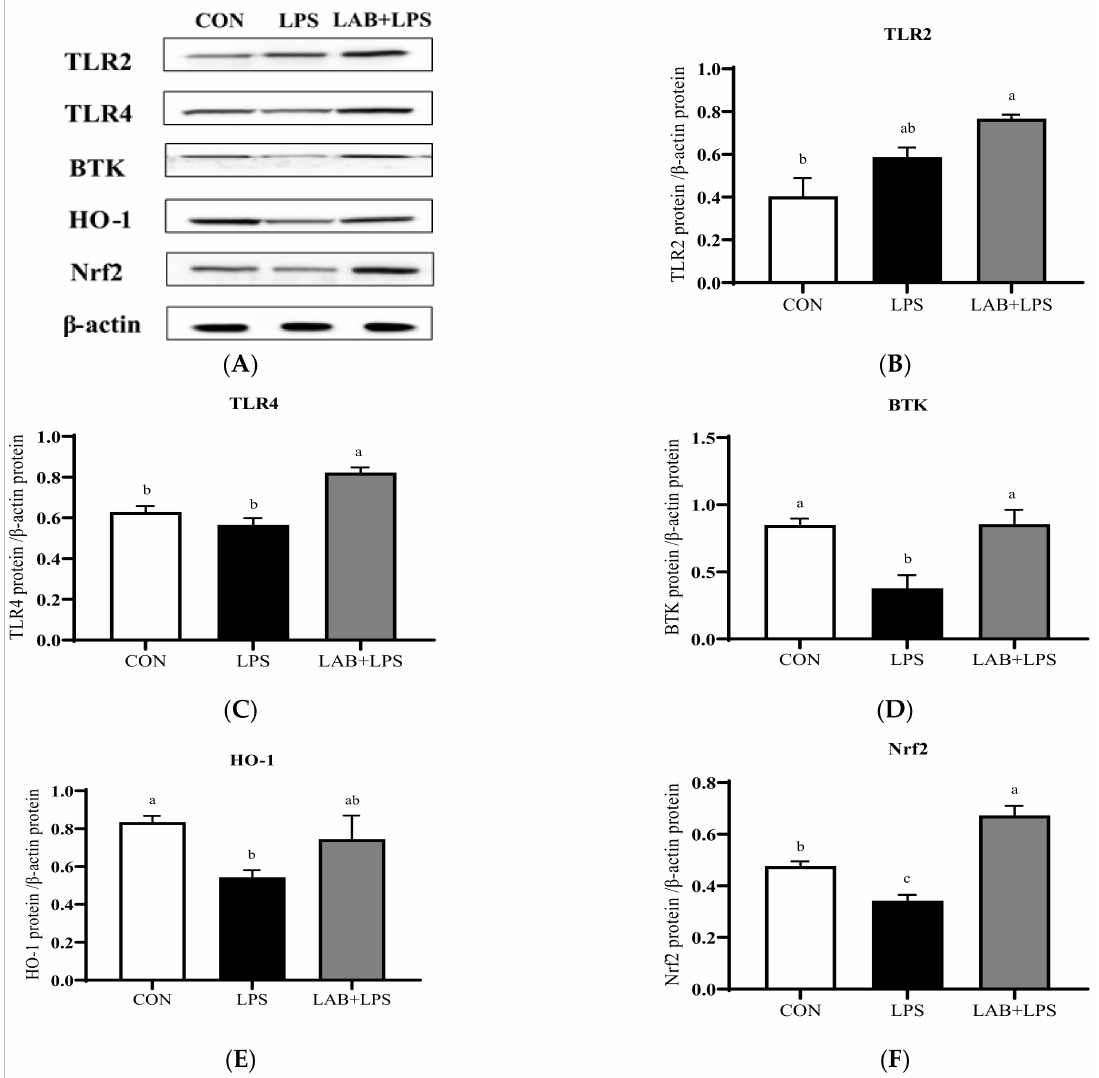
Figure 4. The effects of LAB supplementation on the protein expression of TLRs, Btk, and Nrf2 in the ilea of weaned piglets. Expression based on Western blotting ( A ) and quantification for ( B ) TLR2, ( C ) TLR4, ( D ) Btk, ( E ) HO-1, and ( F ) Nrf2. Data are presented as means ± SEM ( n = 6). a,b,c Mean values within a row with different superscript letters indicate significant differences ( p < 0.05). CON—non-challenged piglets fed a basal diet; LPS—LPS-challenged piglets fed a basal diet; LAB + LPS—LPS-challenged piglets fed a basal diet supplemented with 0.2% LAB. TLR2—Toll-like receptor 2; TLR4—Toll-like receptor 4; BTK—Bruton’s tyrosine kinase; HO-1—hemeoxygenase-1; Nrf2—nuclear factor erythroid 2-related factor